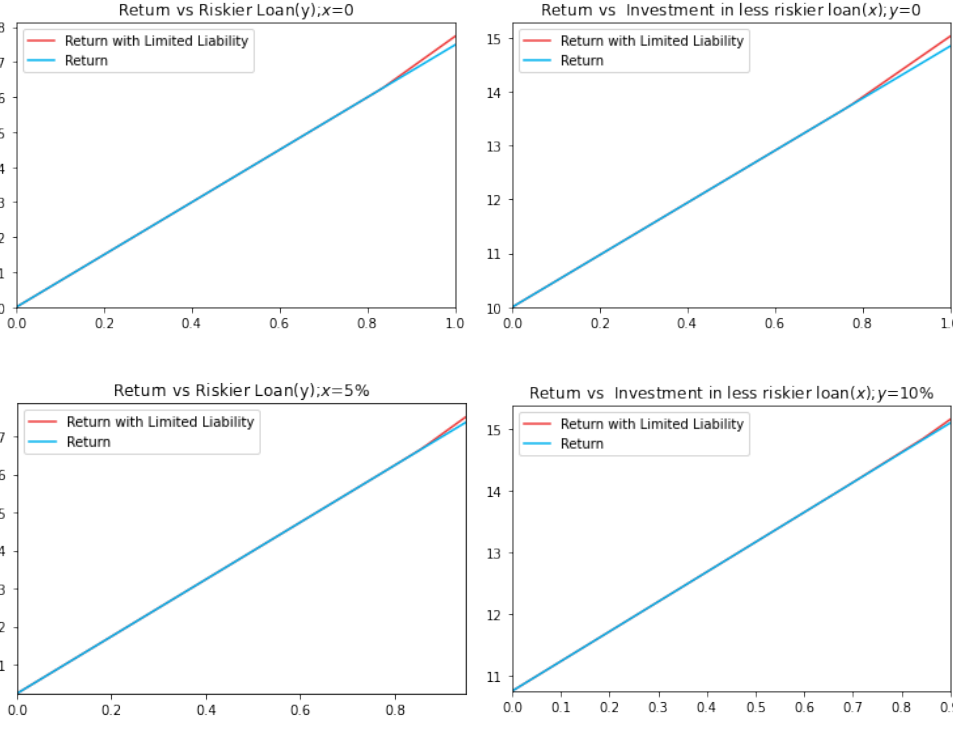
Figure 4. Expected Returns versus risky loans keeping the Leverage Ratio at 4%.